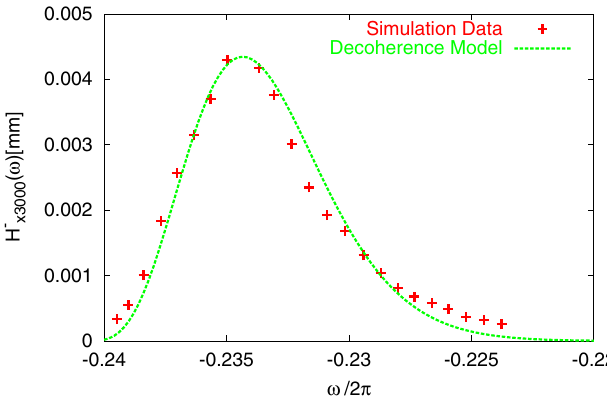
FIG. 4. (Color) Distribution of the line (cid:2)(cid:1) 2 ; 0 (cid:3) for model and simulation against frequency for the SPS with extraction sextu- poles on.